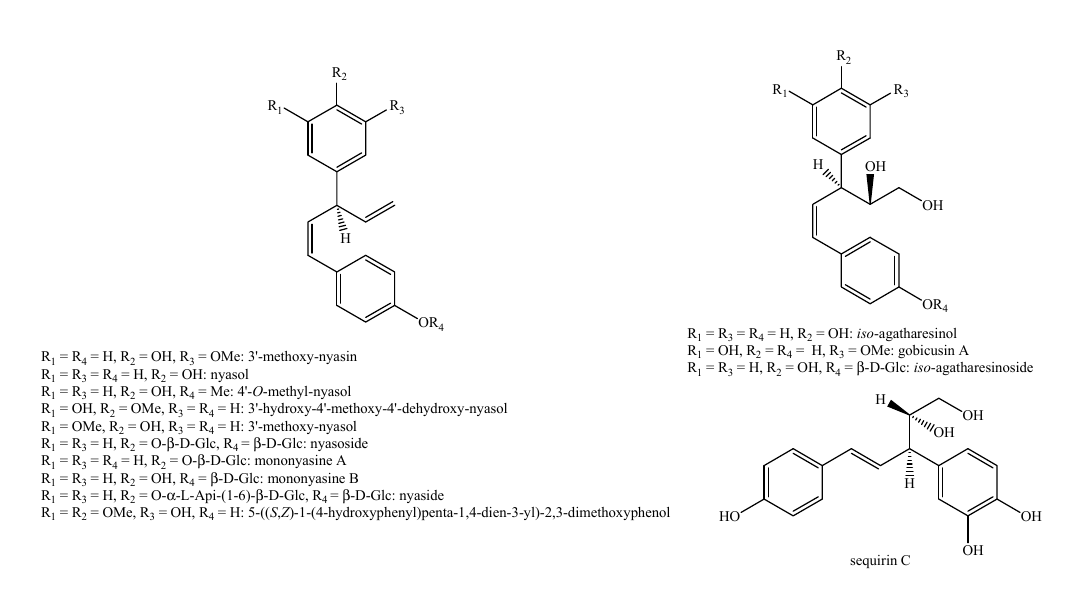
Figure 6. Isolated nor -lignans in the plant kingdom—part 5.